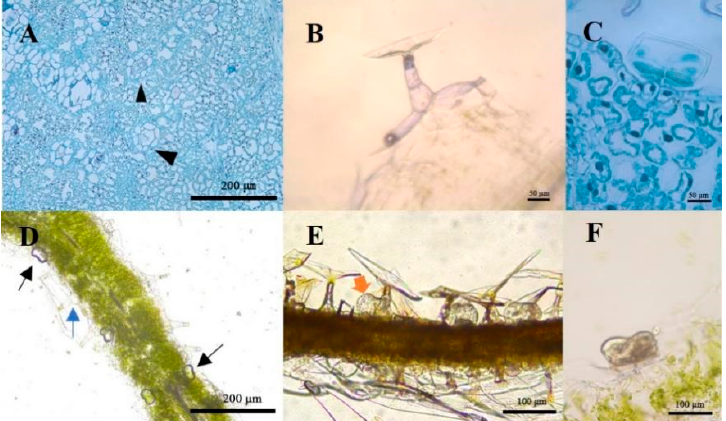
Figure 2. Paraffin section and histochemical staining of the leaf trichomes. Transverse and longitu- dinal paraffin sections of glandular trichomes (black triangles) in mature leaves ( A , C , F ) and T- shaped trichomes ( B ). Nadi staining for terpenes revealed that the volatile terpenoids (black arrows) existed in the subcuticular spaces ( D ). The staining for total lipids (yellow arrow) with Sudan IV suggested the accumulation of total lipids in the subcuticular space ( E ).